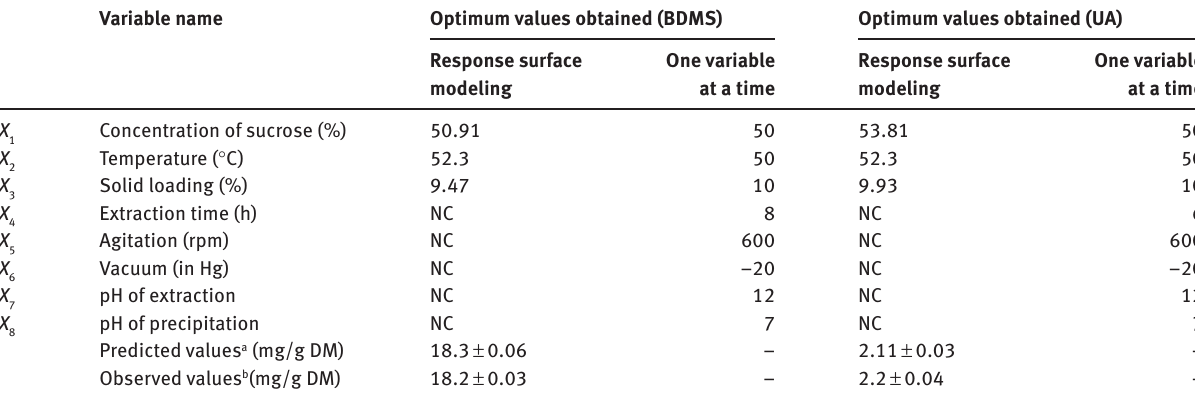
Table 5: Optimum conditions obtained from response surface methodology and one variable at a time